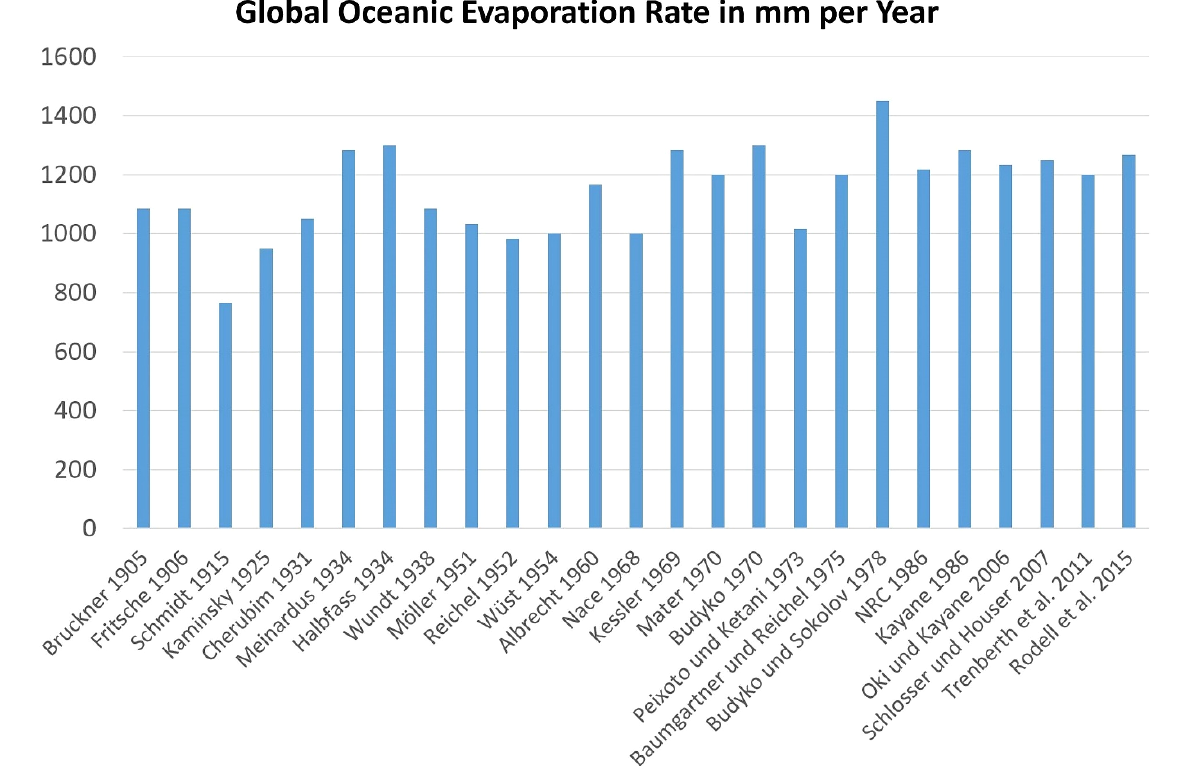
Figure 3. Global averages of the marine evaporation rate in mm per year from various estimates since 1905. All values are adopted from the review article of Peters-Lidard et al. (2019) [61]; the references are also given